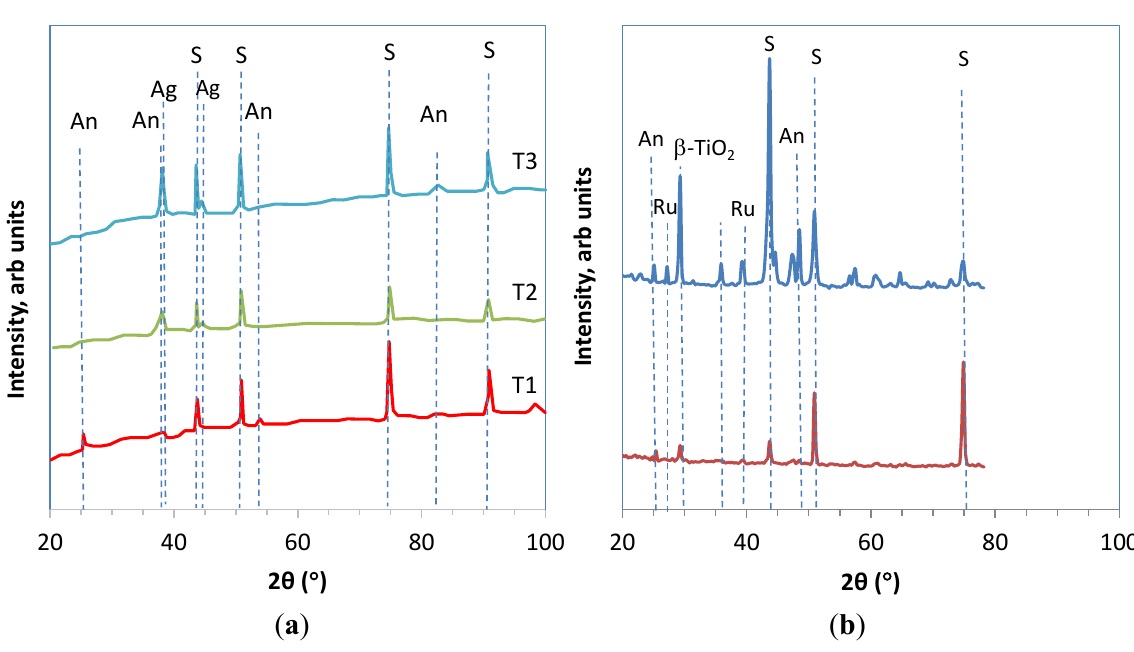
and Mo-TiO coatings after heat treatment (U1 and 2 2